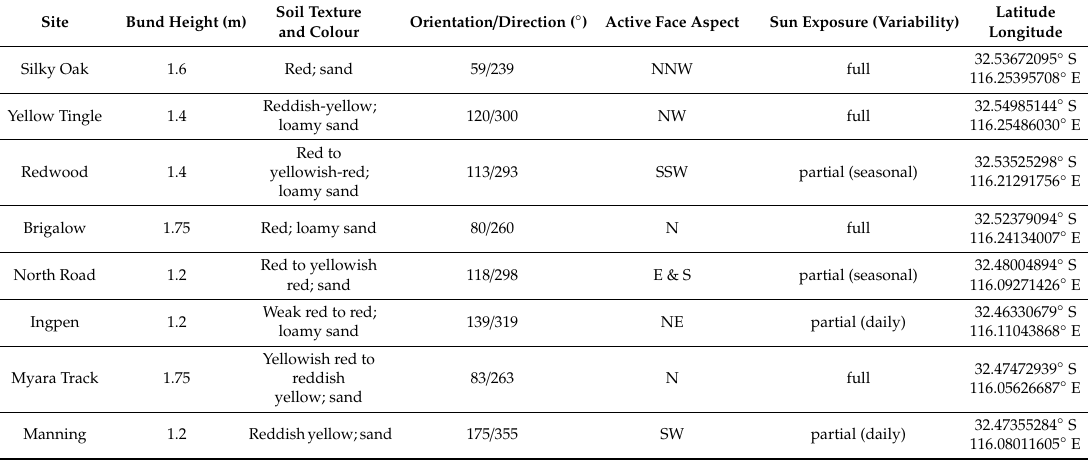
Table 2. Description of bund sites used to test survival of Phytophthora cinnamomi in woody inoculum plugs at 30 cm which were buried on the “active face”. Soil colour: from moist soil based on Munsell colour classification [27]. Soil texture, from soil fraction ≤ 2 mm, based on classification according to Marshall [28] in McDonald et al. [29]. Sun exposure: Partial (daily) = site shaded by adjacent vegetation for part of the day; Partial (seasonal) = site shaded by adjacent vegetation for at least part of the day,